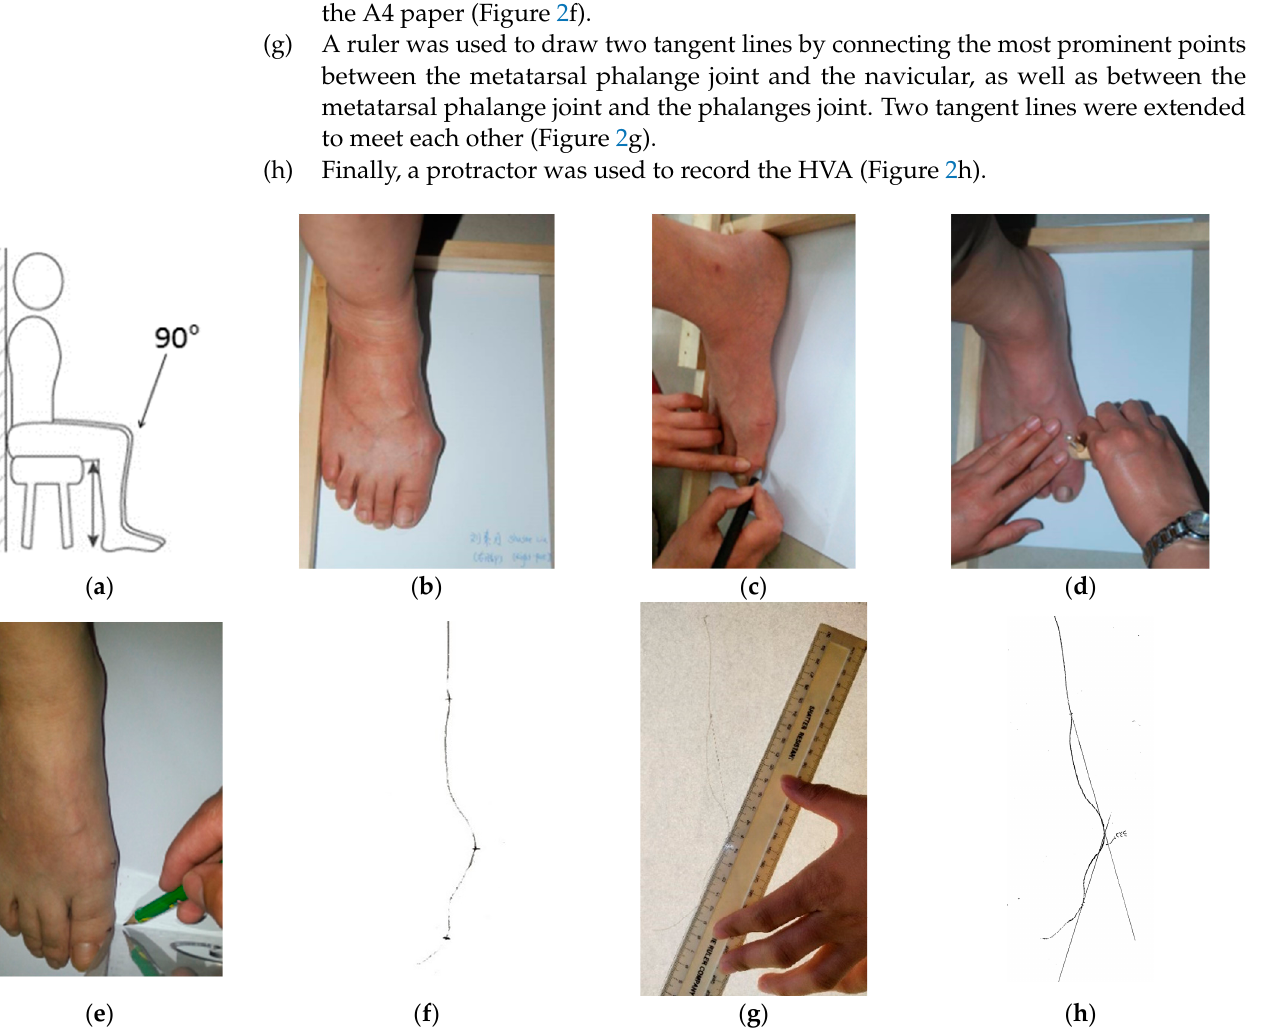
Figure 2. The operating procedure of HVA measurement: ( a ) sit vertically; ( b ) foot close to the corner of the right-angle frame; ( c ) three prominent points of the foot marked by a cross; ( d ) draw a line from the heel to the big toe; ( e ) vertical to mark on the line; ( f ) three prominent points reflected on the traced outline of the foot; ( g ) two tangent lines drawn; ( h ) a protractor used to measure HVA.